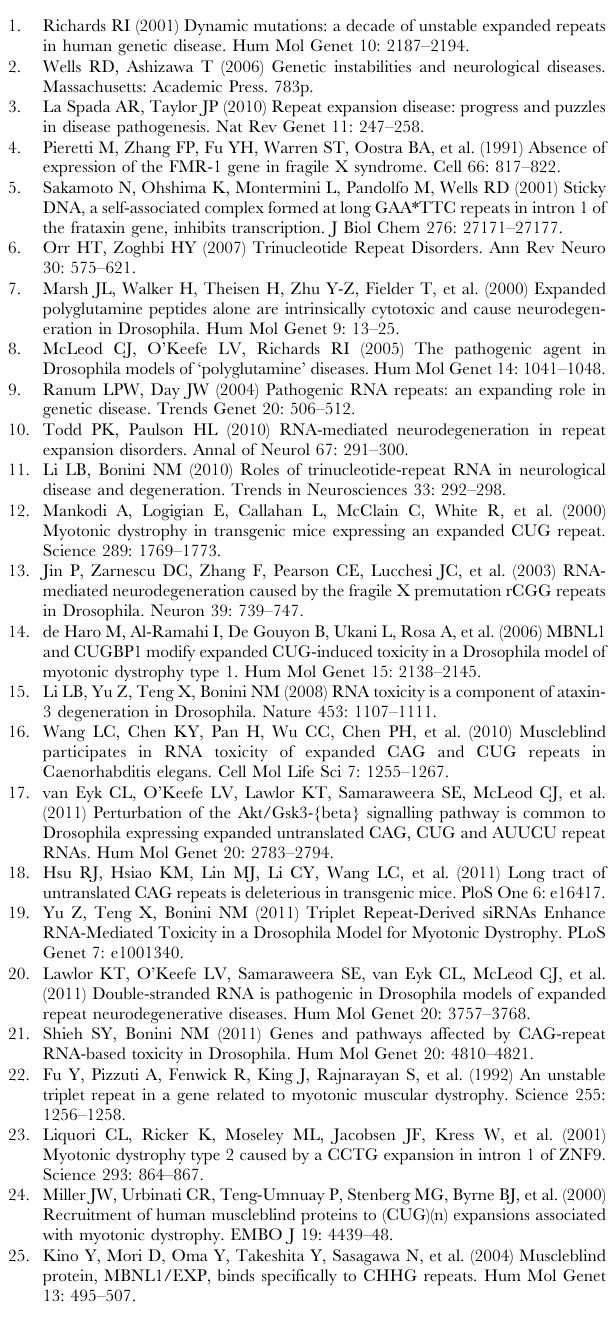
Table S7 Statistical comparison of tergite severity when different mutations are introduced. Tables shows p values from Fisher’s exact test comparing genotypes for the distribution between progeny with any phenotype (category 2, 3 and 4) and others, or between progeny with a strong phenotype (category 3 and 4) and others. In each case comparisons are made to the population expressing each repeat with da-GAL4